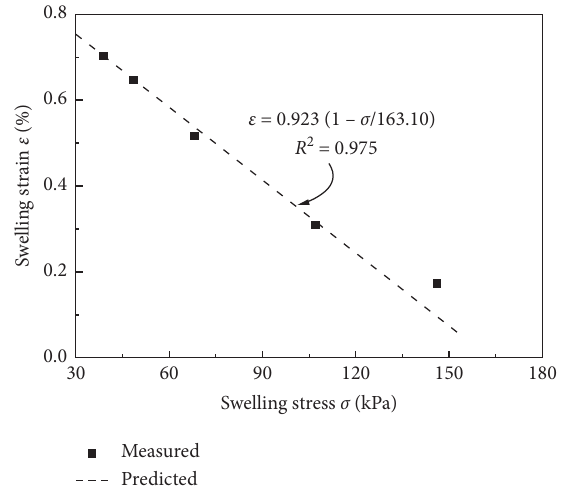
Figure 6: Comparison of measured and calculated swelling test data for red sandstone of Chang et al. [14]. Table 4: Experimental data of Liu et al. [11].